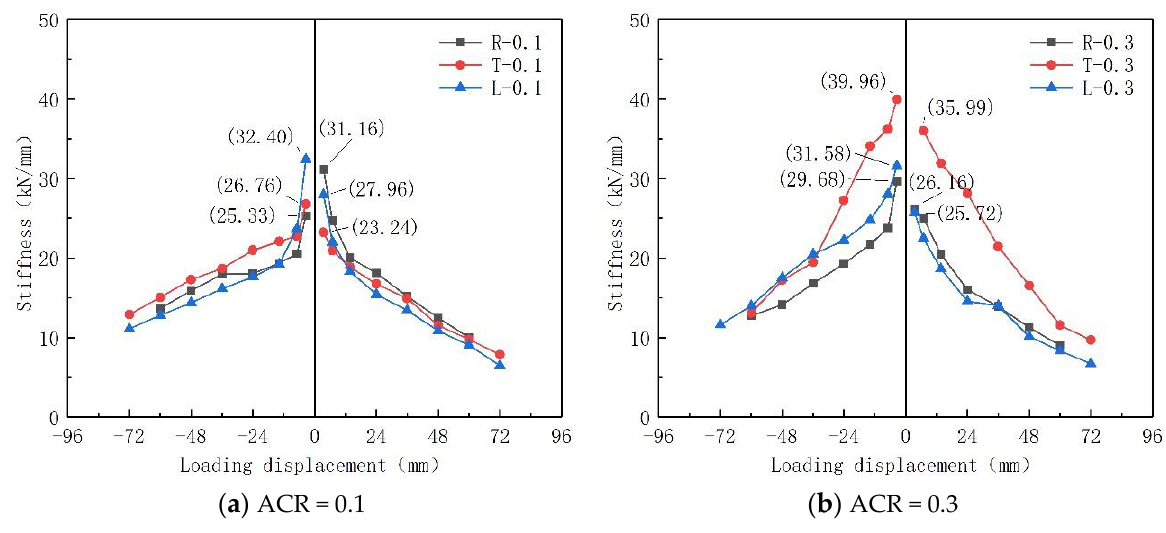
Figure 13. Stiffness degradation curve.